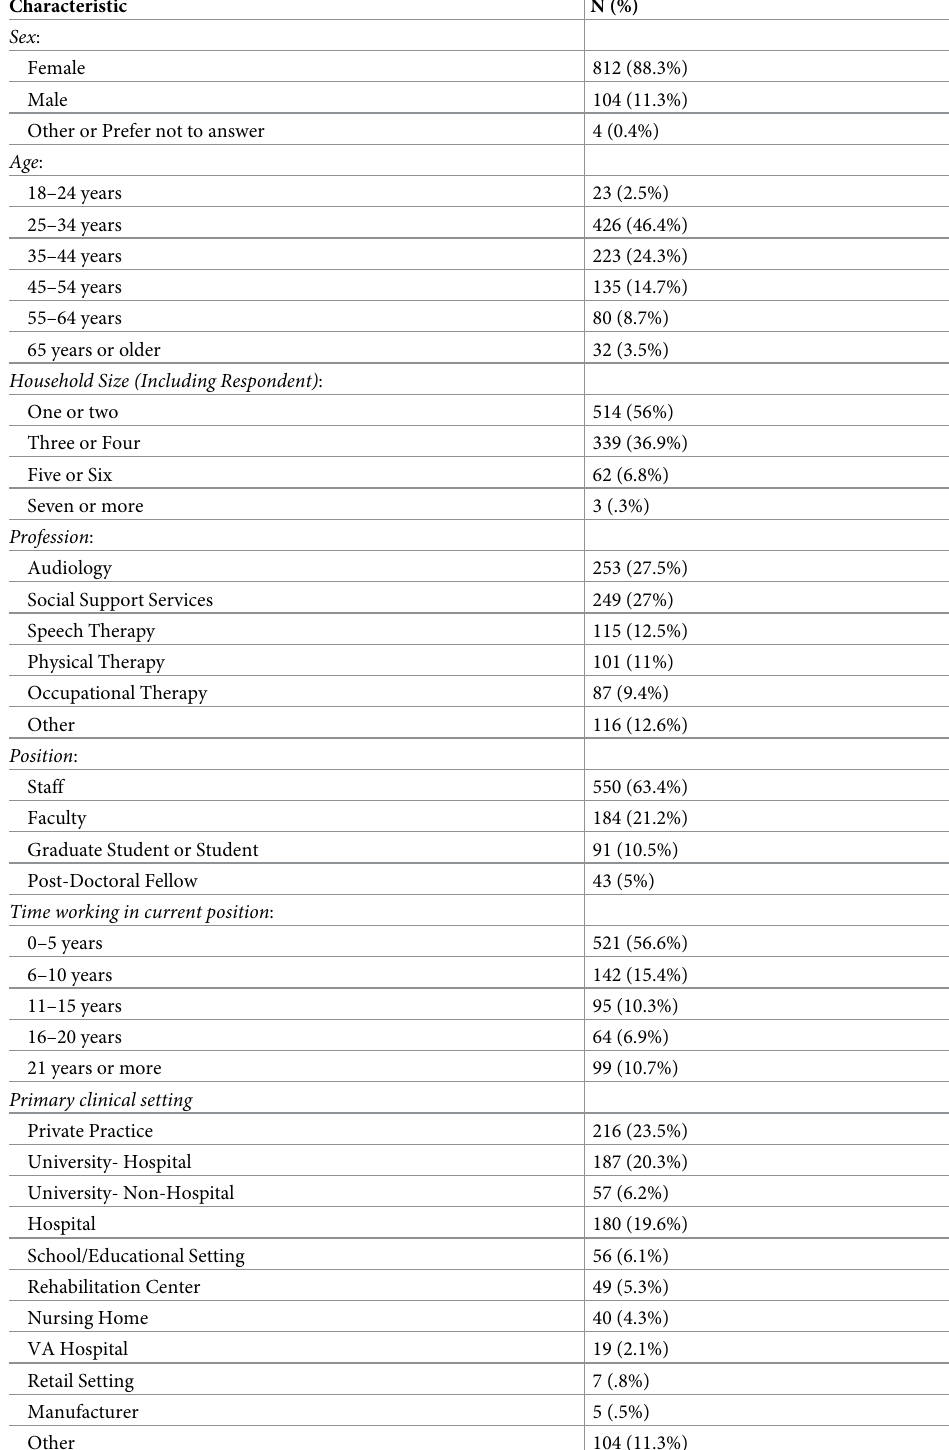
Table 1. Respondent